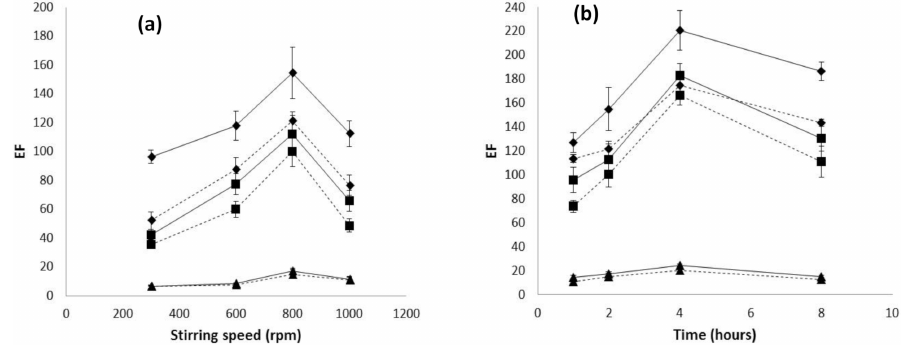
Figure 2. Variation of EF with ( a ) stirring speed and ( b ) time for the three evaluated hollow fiber types: (cid:7) Accurel PP 50 / 280, (cid:4) Accurel PP Q3 / 2, and (cid:78) Accurel PP S6 / 2. Dotted line represents 20 µ L acceptor solution and Solid line represents 40 µ L acceptor